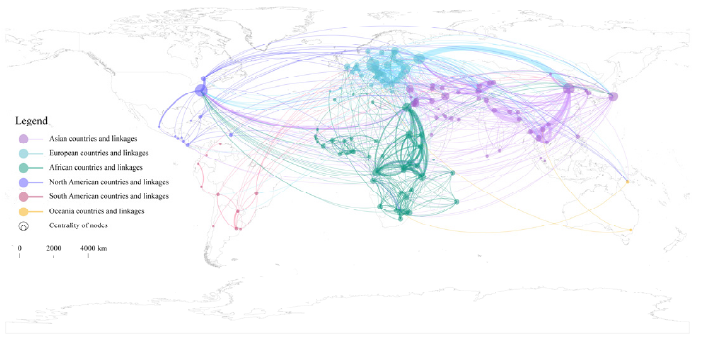
Figure 4. Spatial pattern of transboundary water cooperation linkages based on frequency weighting.